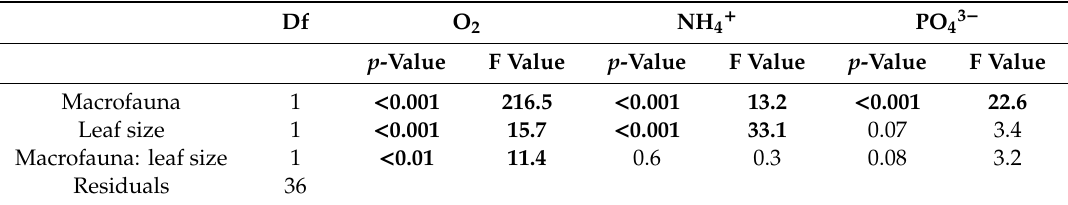
Table 1. Summary of results of two-way Analysis of Variance (ANOVA) testing the e ff ects of factors macrofauna and leaf size on benthic respiration (O 2 ) and nutrient fluxes (NH 4 + , PO 43 − ) measured on day 5. Significant values are printed in bold.